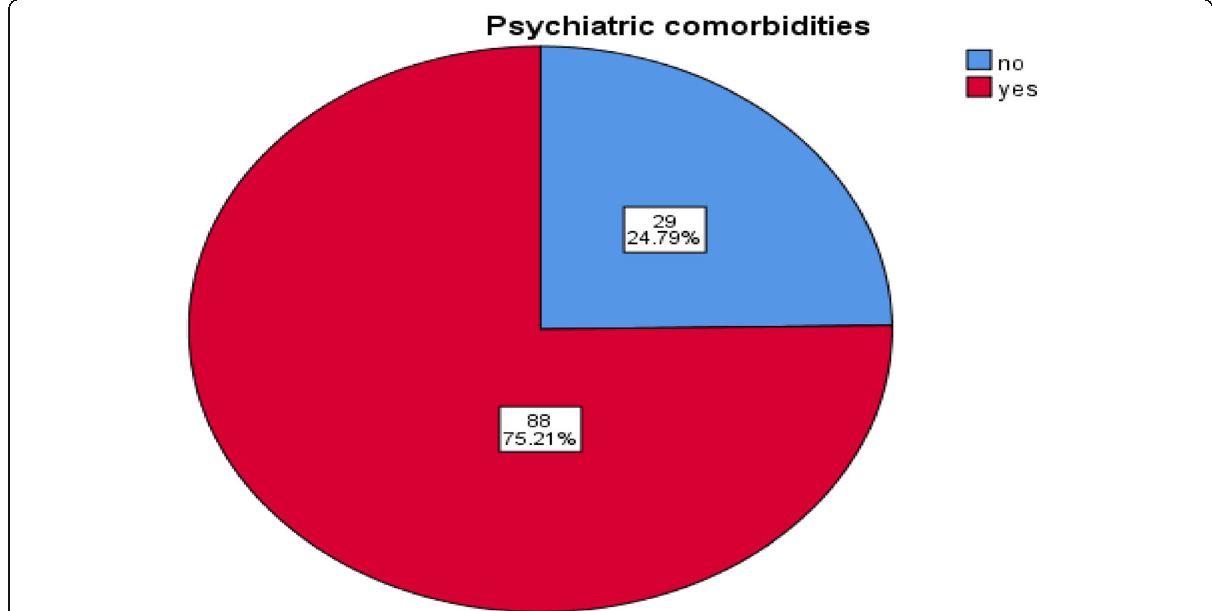
Fig. 2 Presence of psychiatric comorbidities among the ESRD